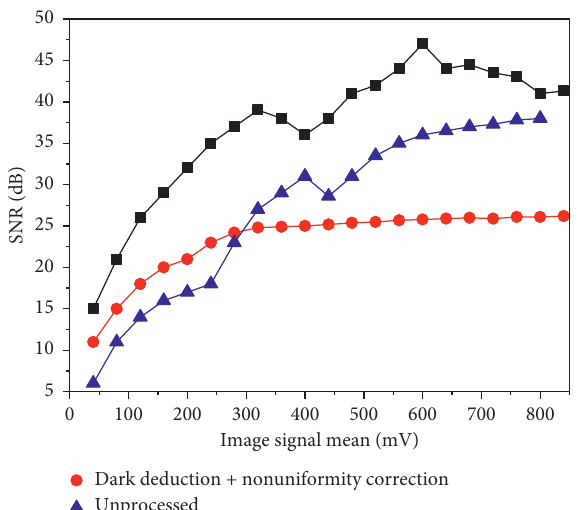
Figure 12: Comparison of imaging effects before and after